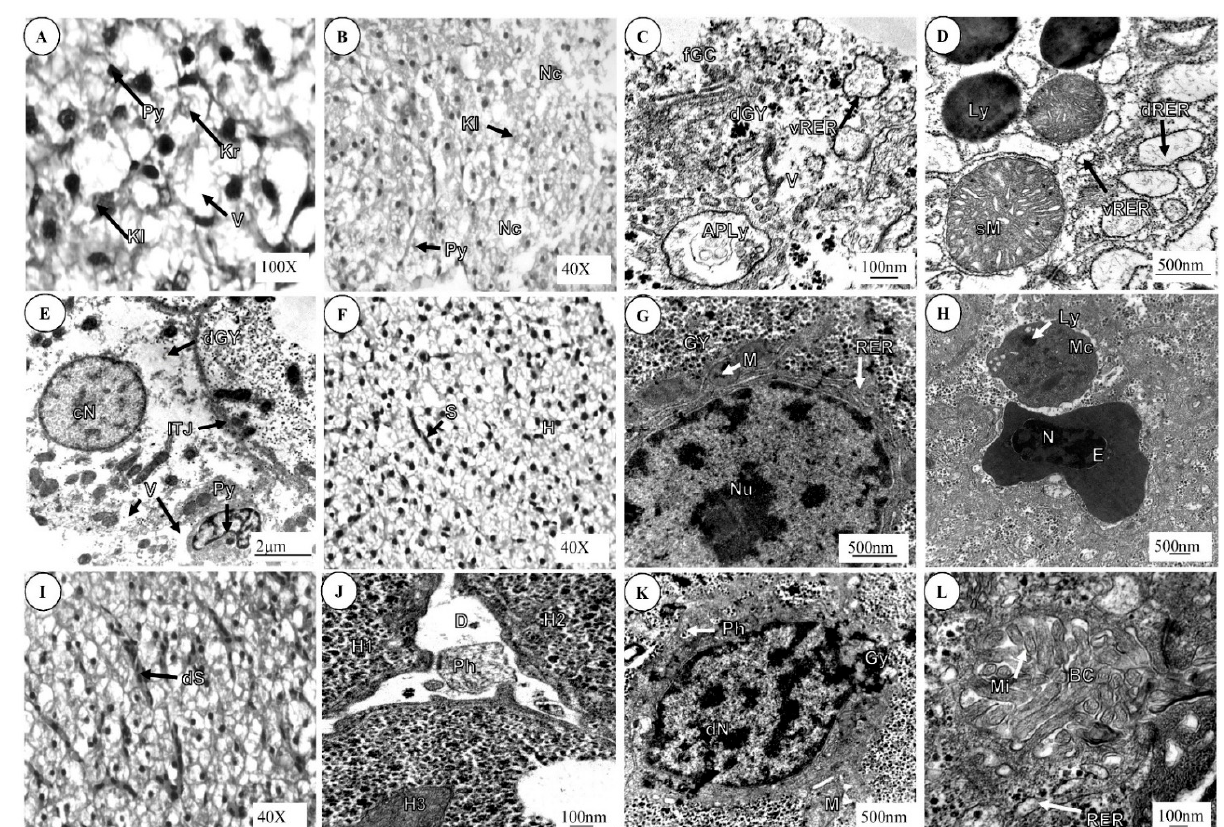
Figure 4. Alterations in C. carpio hepato-architecture after exposure to malachite green and E. officinalis for 60 days. MG: ( A ) (100×) and ( B ) (40×)—Prominent nuclear alterations such as pyknosis (Py), karyolysis (Kl) and cytoplasmic vacuolation (V) and necrotic hepatocytes (Nc). ( C ): vesiculated RER (vRER), vacuolation (V), auto-phagolysosome (APLy), fragmented GC (fGC) and depleted glycogen content (dGY). ( D ): RER transformation into dilated RER (dRER) and vesiculated RER (vRER), prominent lysosomes (Ly) and highly swollen mitochondria (sM). ( E ): Compact nucleus (cN), lost tight junction integrity (lTJ), sparse distribution of glycogen (dGY), vacuolation (V) and pyknosis (Py). E. officinalis : ( F ) (40×)—Hepatocytes (H) with interspersed sinusoids (S). ( G ): Regular hepatocyte architecture comprising nucleolus (Nu) in nucleus (N), RER extension from nuclear membrane, mitochondria (M) in vicinity and glycogen abundance (GY). ( H ): Sinusoid (S) showing macrophage with lysosomes (Ly) and erythrocyte (E) with central nucleus (N). MG + E. officinalis : ( I ) (40×)—Protected liver showing fewer nuclear alterations and dilated sinusoid (dS). ( J ): Phagosome (Ph) in space of Disse (D) formed by surrounding the hepatocytes (H1–H3). ( K ): Deformed nucleus (dN), phagosomes (Ph), mitochondria (M) and restored glycogen content (GY). ( L ): Bile canaliculi (BC) with regular microvilli (Mi) and interspersed RER.